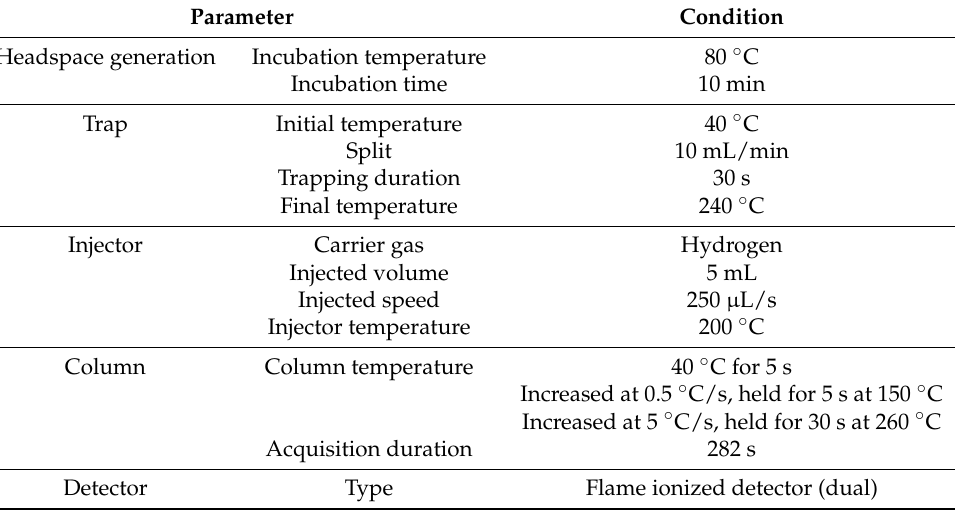
Table 1. Analytical conditions of electronic nose for volatile compounds in dry- and wet-aged beef strip loins during 28 days of